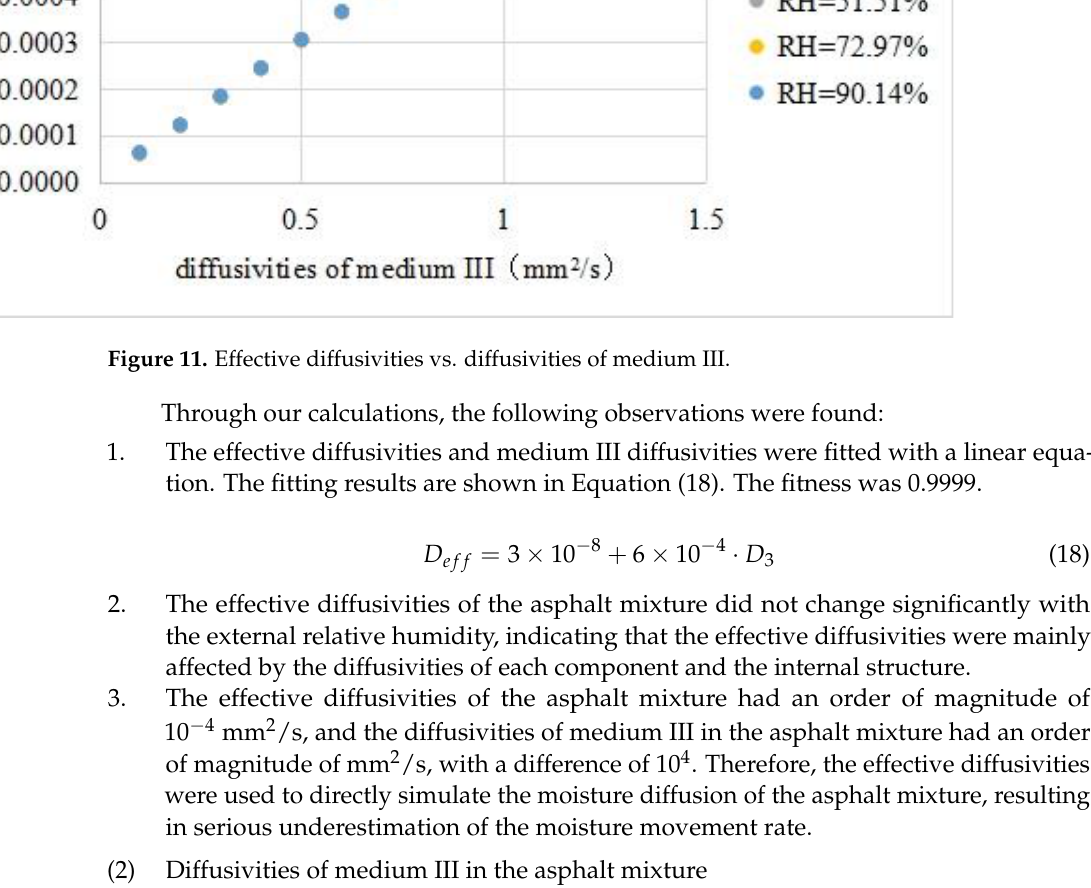
Table 11. Water vapour diffusion parameters of the asphalt mixture.